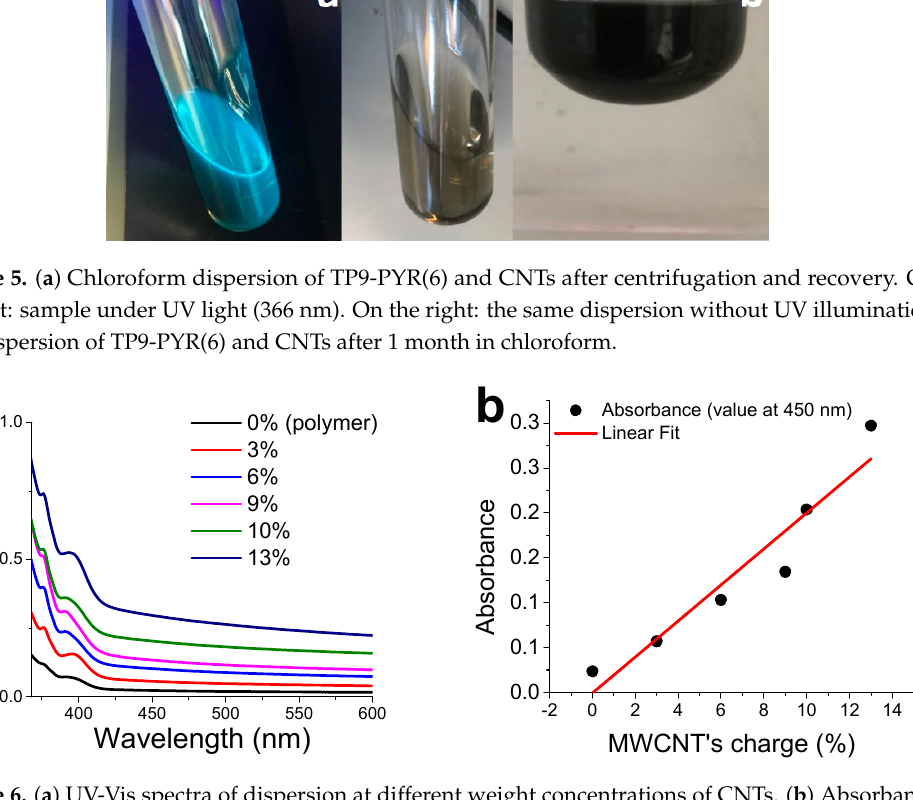
Figure 6. ( a ) UV-Vis spectra of dispersion at different weight concentrations of CNTs. ( b ) Absorbance values (taken at 540 nm) versus CNTs charge, the red line is the applied linear fit. Table 4. CNTs effective charge registered from the two-dispersion Table 5. CNTs effective charge registered from the two-dispersion sequences.